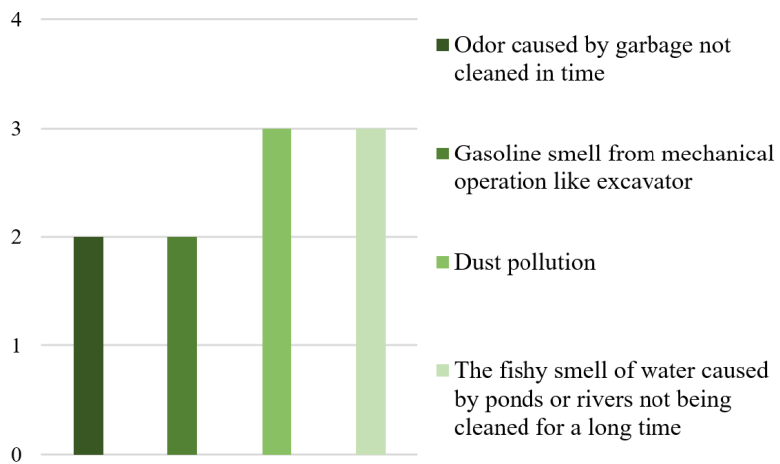
Figure 8. The reasons that children thought the air in urban forest parks was not fresh ( n = 4).